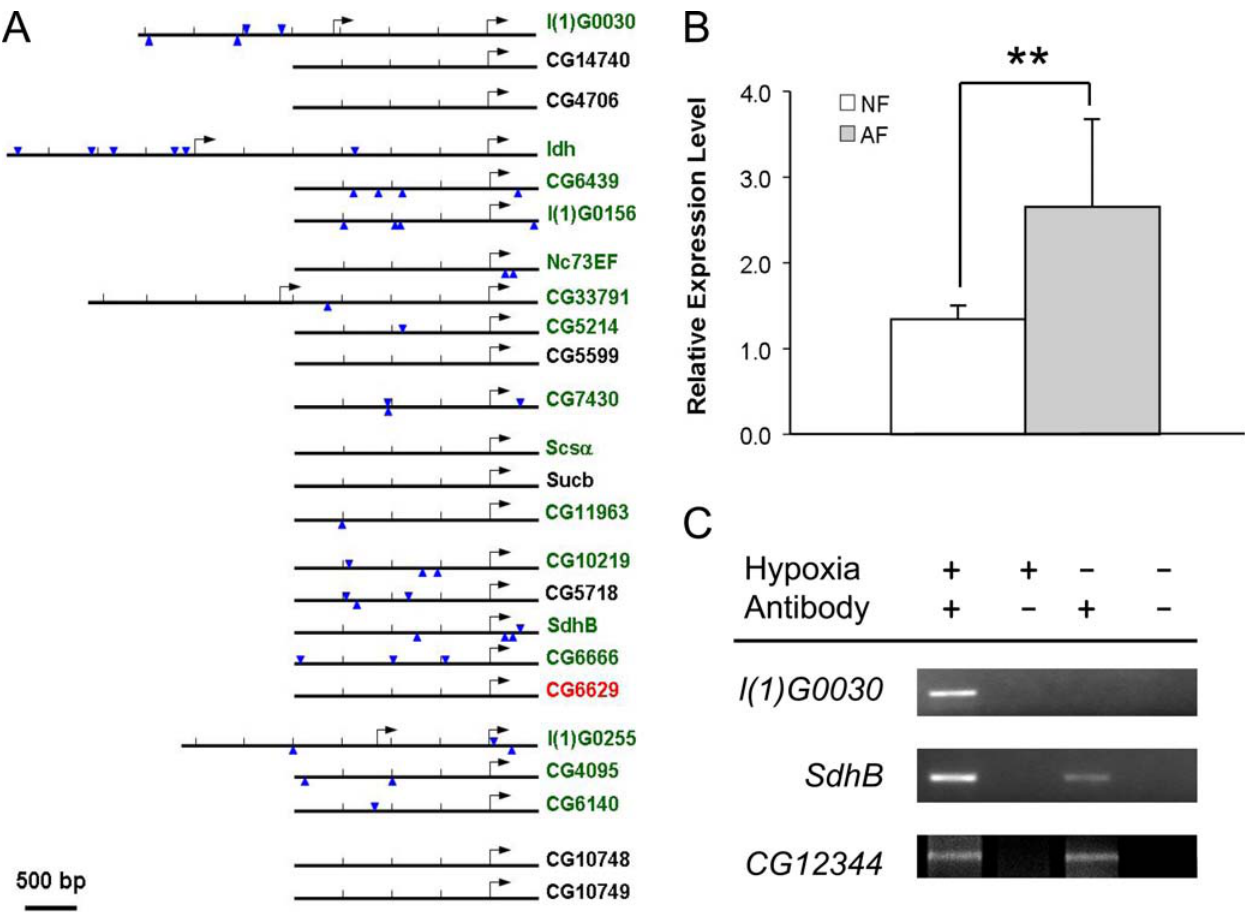
Figure 6. Effect of the transcriptional suppressor, hairy , on TCA cycle gene expression and hypoxia tolerance. A) Genomic localization of hairy binding elements in the cis -regulatory region of genes encoding TCA cycle enzymes. Arrowheads indicate consensus hairy binding sites and arrows indicate transcriptional start sites. B) Significant up-regulation of hairy expression in hypoxia-selected AF populations (p , 0.01). C) Chromatin immunoprecipitation assay of gene l(1)G0030 , SdhB and CG12344 under normoxia or hypoxia.